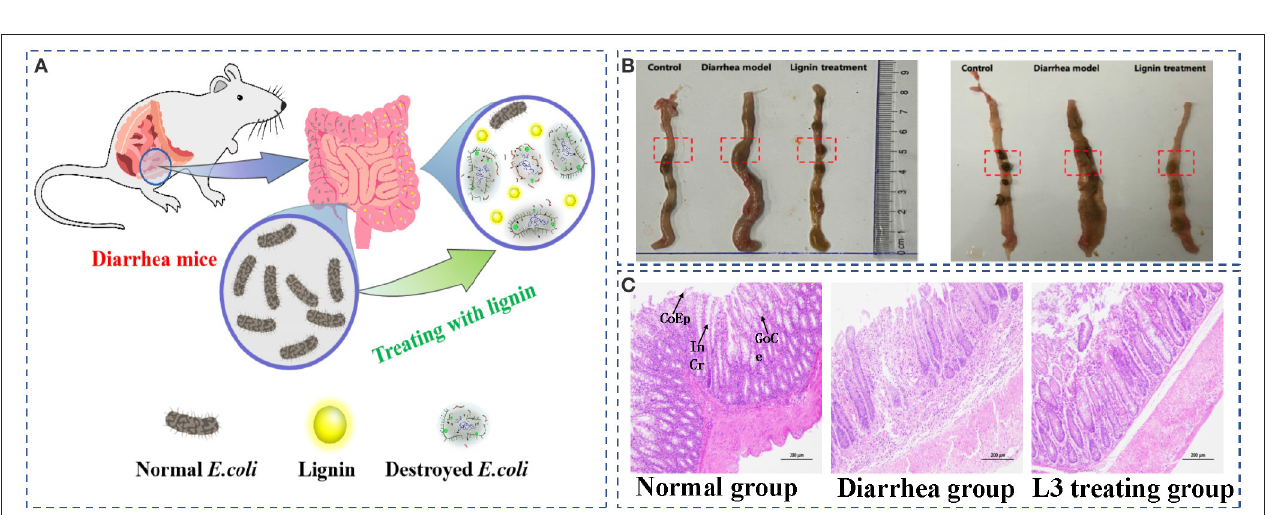
effects on bacterial infection-induced intestinal damage in mice. These results showed that the L3 lignin had the ability to ameliorate E. coli diarrhea damages, which showed an excellent in vivo antimicrobial